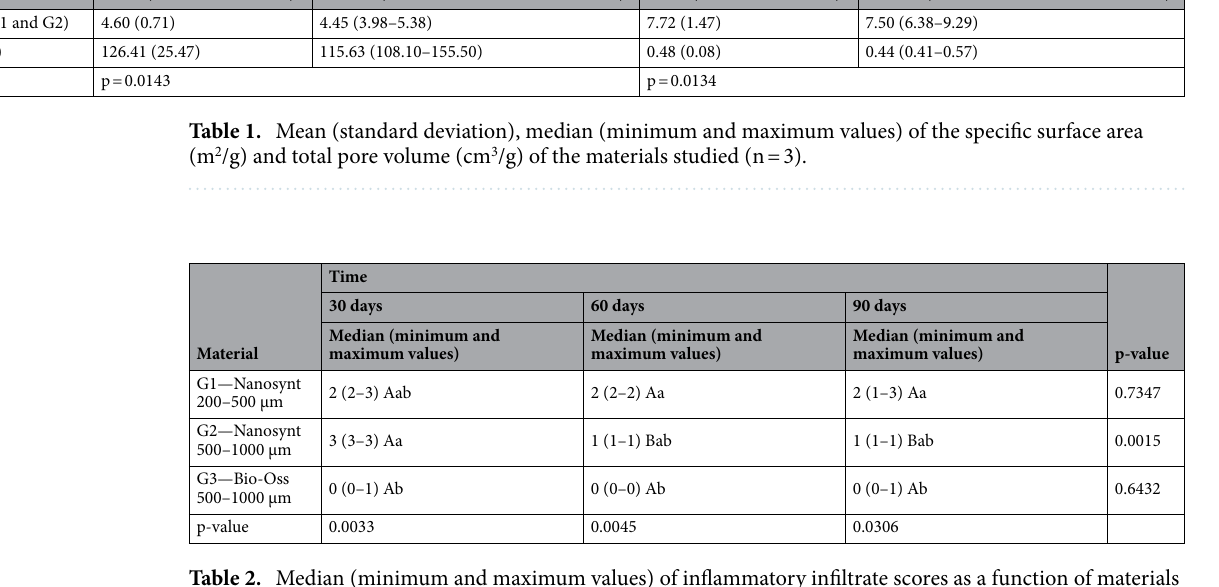
Table 2. Median (minimum and maximum values) of inflammatory infiltrate scores as a function of materials and time. Distinct letters (vertical case and horizontal capital) indicate statistically significant differences (p ≤ 0.05). Absent (0); Mild (1), up to 25%; Moderate (2), from 25 to 50%; Intense (3), above 50%.